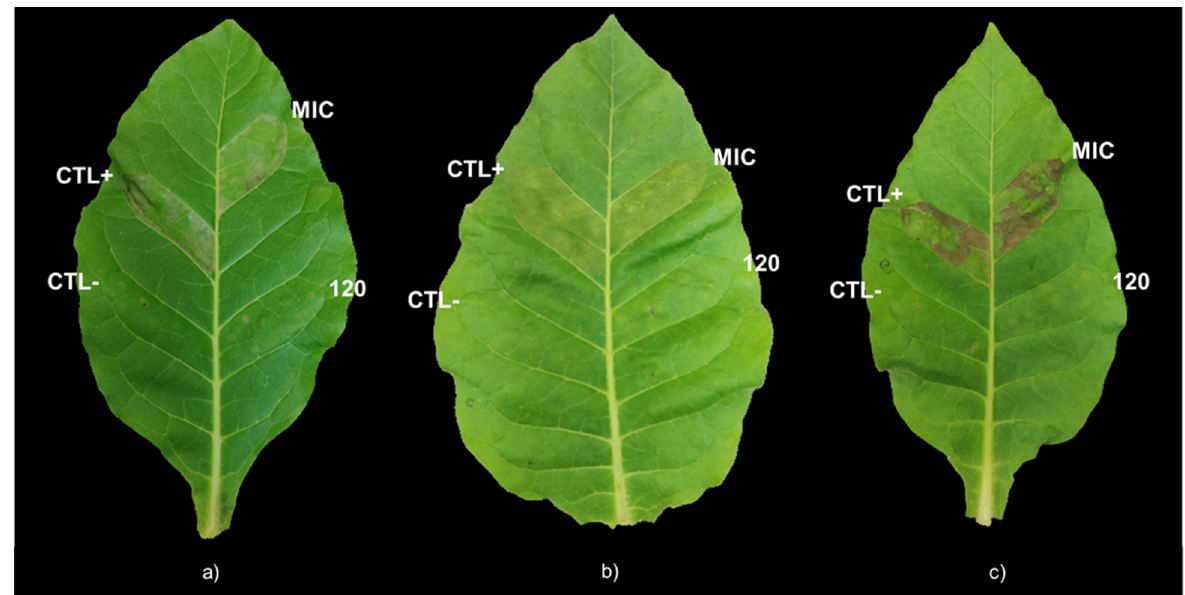
Figure 3. Hypersensitive response on tobacco leaves upon 48 h of infiltration of PBS buffer (negative control; CTL − ), and of Pseudomonas syringae pv. tomato DC3000 ( a ), Xanthomonas euvesicatoria LMG 905 ( b ), and Clavibacter michiganensis michiganensis LMG 7333 ( c ) resuspended in PBS buffer (positive control; CTL+) and treated with the minimal inhibitory concentration (MIC), and DLE at 120 g L − 1 (120).